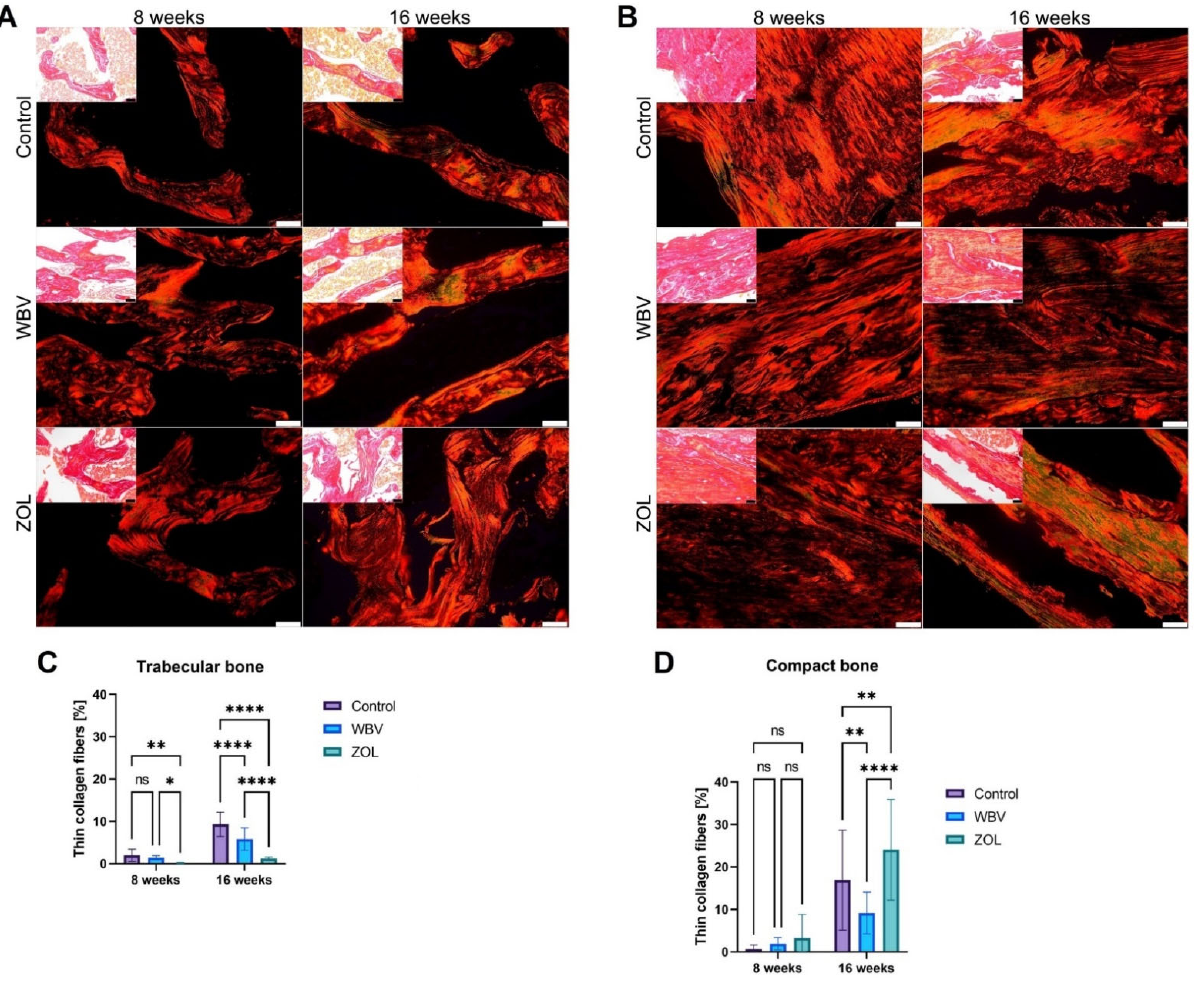
Figure 4. Thin (immature) collagen content in femora trabeculae in rats subjected to obesity and immobility: representative images of PRS ‐ stained sections of ( A ) trabecular and ( B ) compact bone observed in polarized light (big images) and bright light (small images). The thin, immature collagen fibers are green and the mature fibers are orange or red. Insets: the same sections observed in bright ‐ field. All scale bars represent 50 μ m; bar graphs of thin (immature) collagen content in ( C ) femora trabeculae and ( D ) femora compact bone. Data are mean values ± SD from n = 6 rats. Control—the control group included rats subjected to obesity and immobility not treated with WBV or ZOL; WBV—the WBV group included rats subjected to obesity and immobility with whole ‐ body vibration treatment (30 min, 5 days per week); ZOL—the ZOL group included rats subjected to obesity and immobility and injected intramuscularly with zoledronic acid at a dose of 0.025 mg/kg body weight every 4 weeks. Statistical significance: ns—not significant; * p < 0.05; ** p <0.01; **** p < 0.0001 (Tukey’s HSD test or Kruskal–Wallis H test).